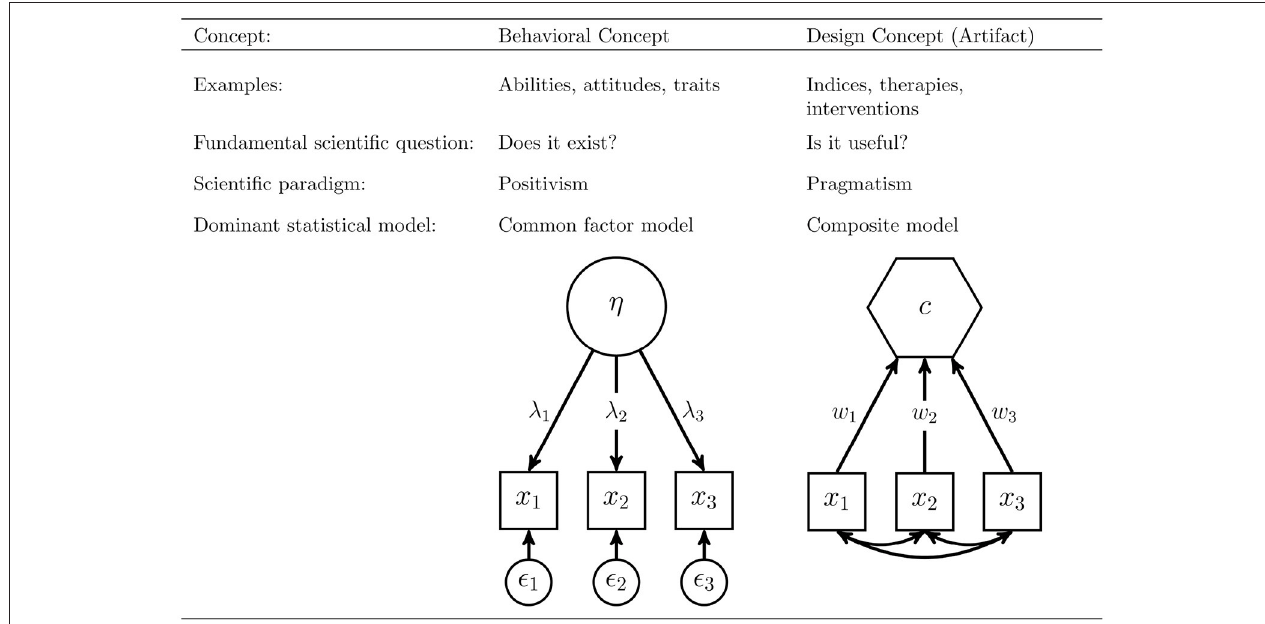
FIGURE 1 | Two types of concepts: behavioral concepts vs. artifacts.